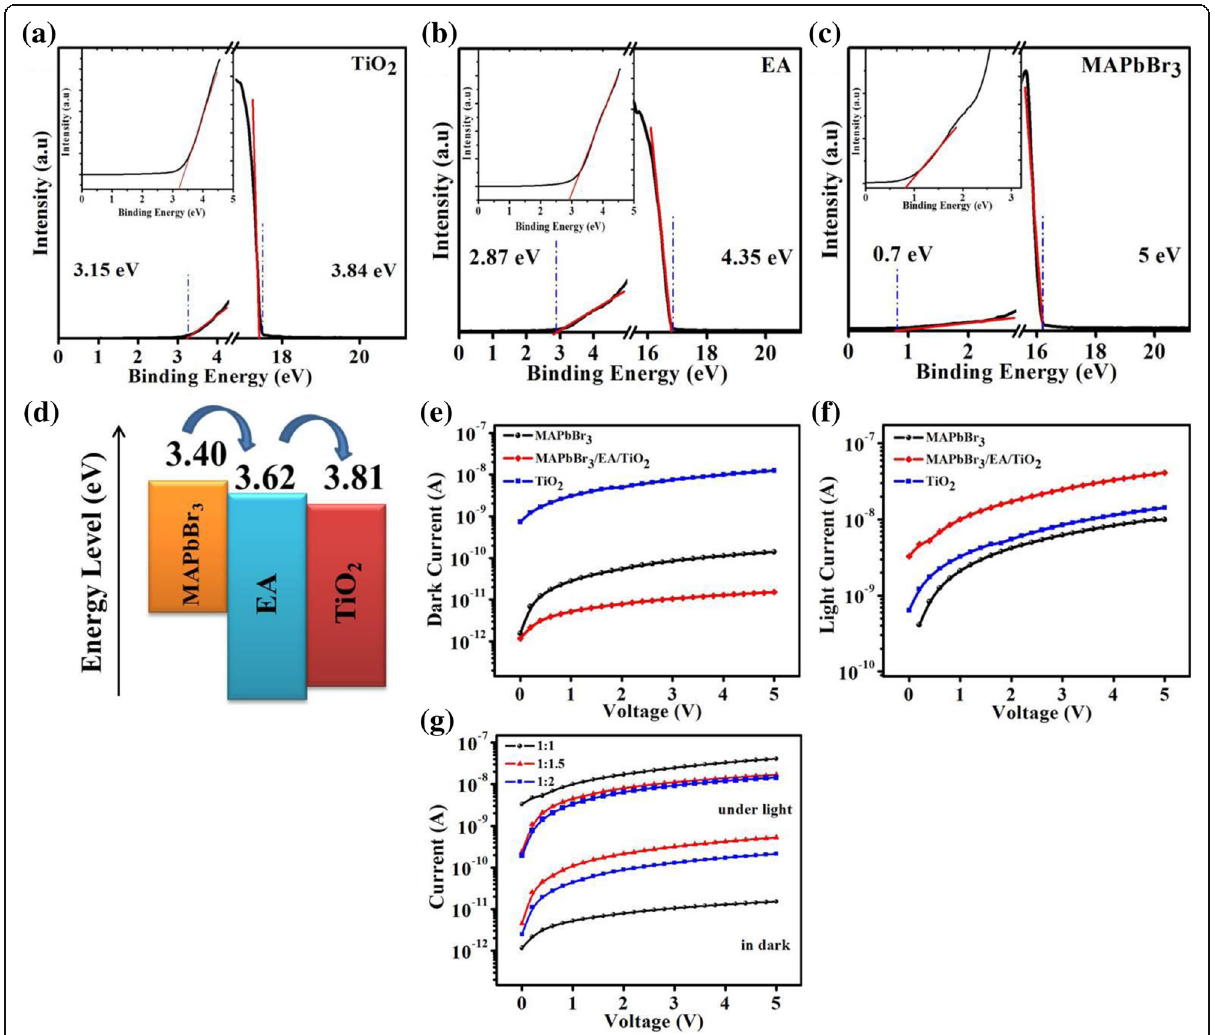
Fig. 4 The UPS (ultraviolet photoelectron spectra) of a TiO 2 film. b Ethanolamine film. c MAPbBr 3 film. d Energy band diagram. I – V characteristics of photodetector devices at optimal ratio (1:1): e under dark, f under the light with intensity of 0.50 mW cm − 2 . g I – V characteristics of trilayer photodetector at different ratios of